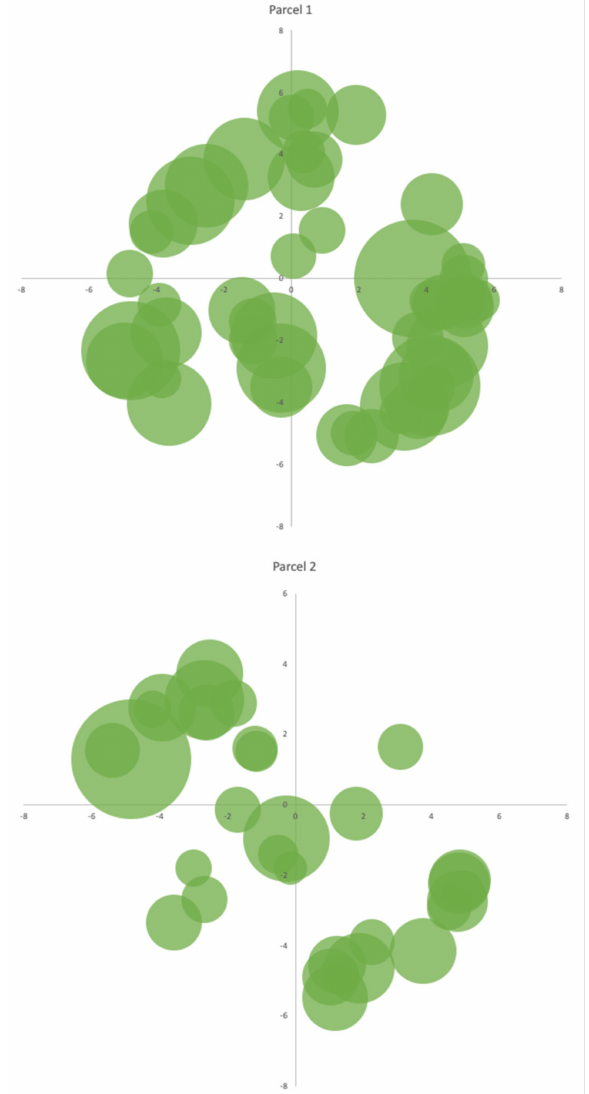
Figure 6. Distribution of A. dealbata trees in Parcels 1 and